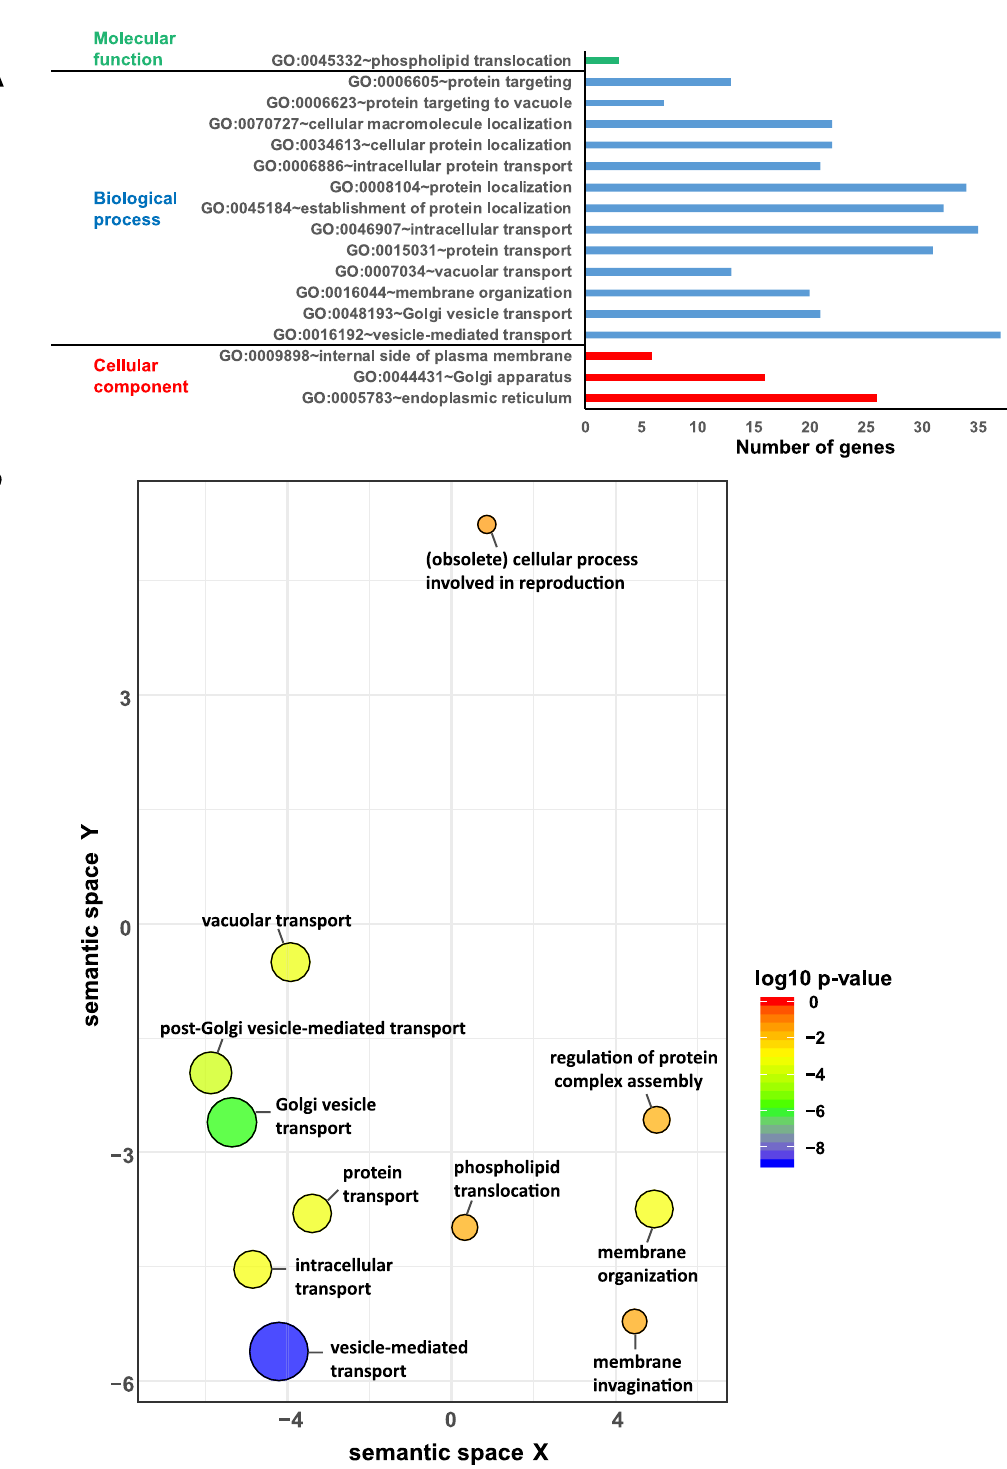
Fig 4. Gene Ontology (GO) analysis of genes conferring resistance to auroramycin. (A)Enrichment of GO categories in Biological process, Cellular component and Molecular function among the top cluster of genes conferring resistance to auroramycin (log FC < -0.5 and P-value < 0.05) was determined using DAVID. Number of genes in the GO category is indicated by the horizontal bar. Details of genes in each category are provided in the S1 Table. (B)Enrichment of GO categories in Biological process among the top genes conferring resistance (log FC value < -0.5 and P-value < 0.05) to auroramycin was visualized using REVIGO. Bubble colour refer to the p-value for the false discovery rates whilst circle size gives the frequency of the GO term in the underlying GO database (bubbles of more general terms are larger;